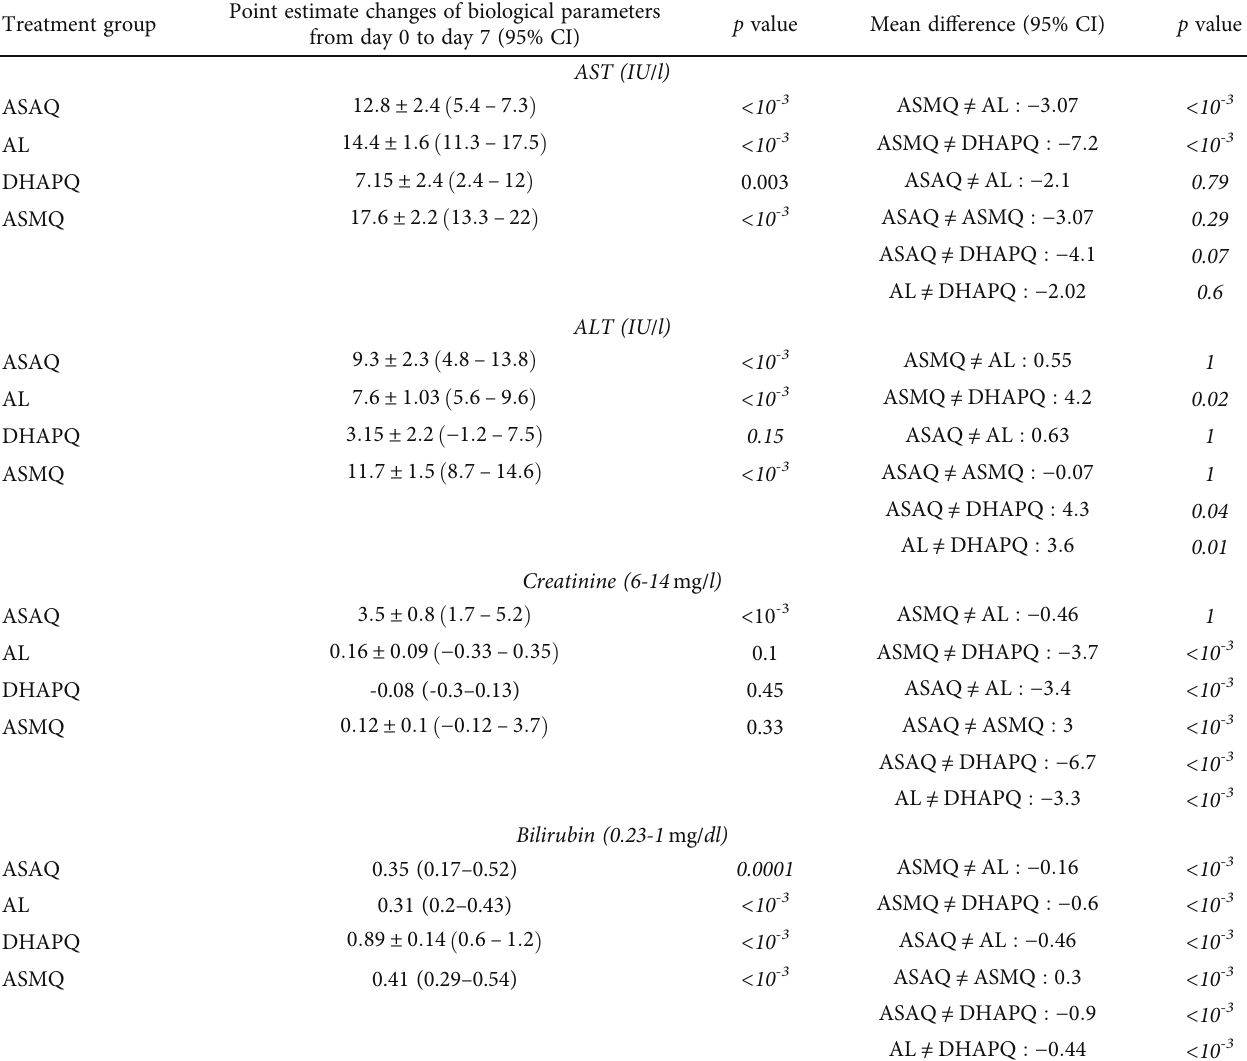
Table 5: Biochemical parameter changes from day 0 to day 7 by treatment arms. Treatment